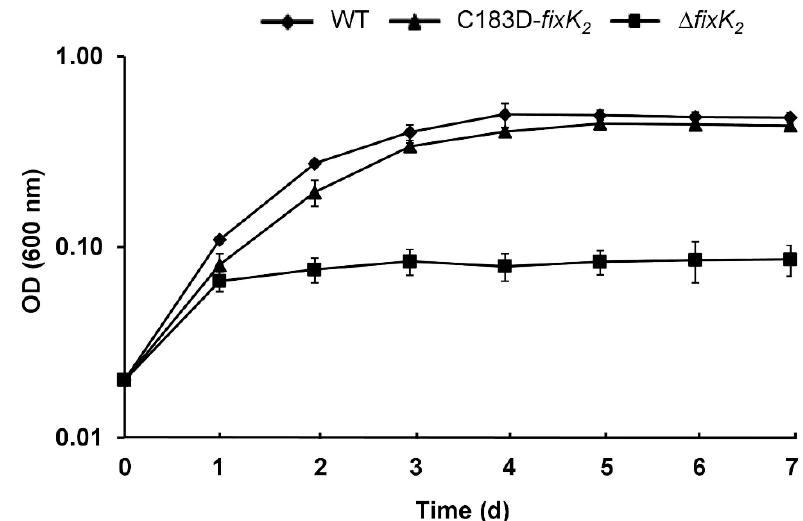
Figure 5. Denitrifying growth of the B. diazoefficiens C183D- fixK 2 strain (triangles). Wild type (WT, diamonds) and Δ fixK 2 (squares) were used as controls. Cells were grown anoxically with nitrate. Values ± standard errors are the mean of a representative experiment carried out with three parallel cultures. At least three replicates of the experiment were done.